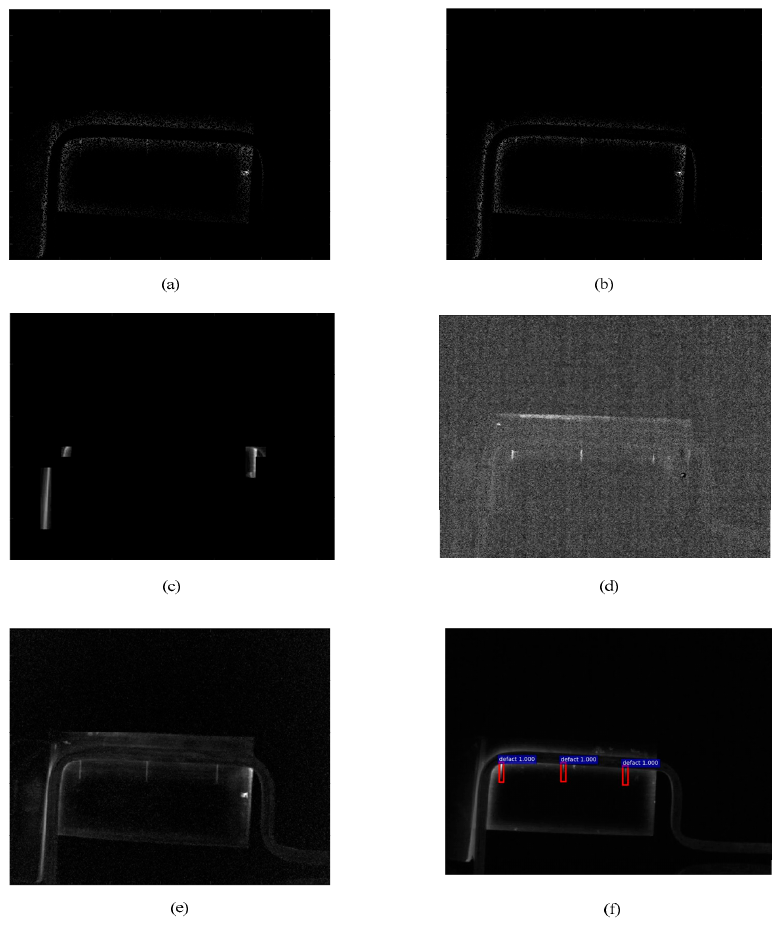
Figure 5. Detection results provided by different algorithms on sample (a): ( a ) TSR; ( b ) PPT; ( c ) ARDVB; ( d ) EVBTF; ( e ) SVD ‐ RARX; ( f ) proposed method.